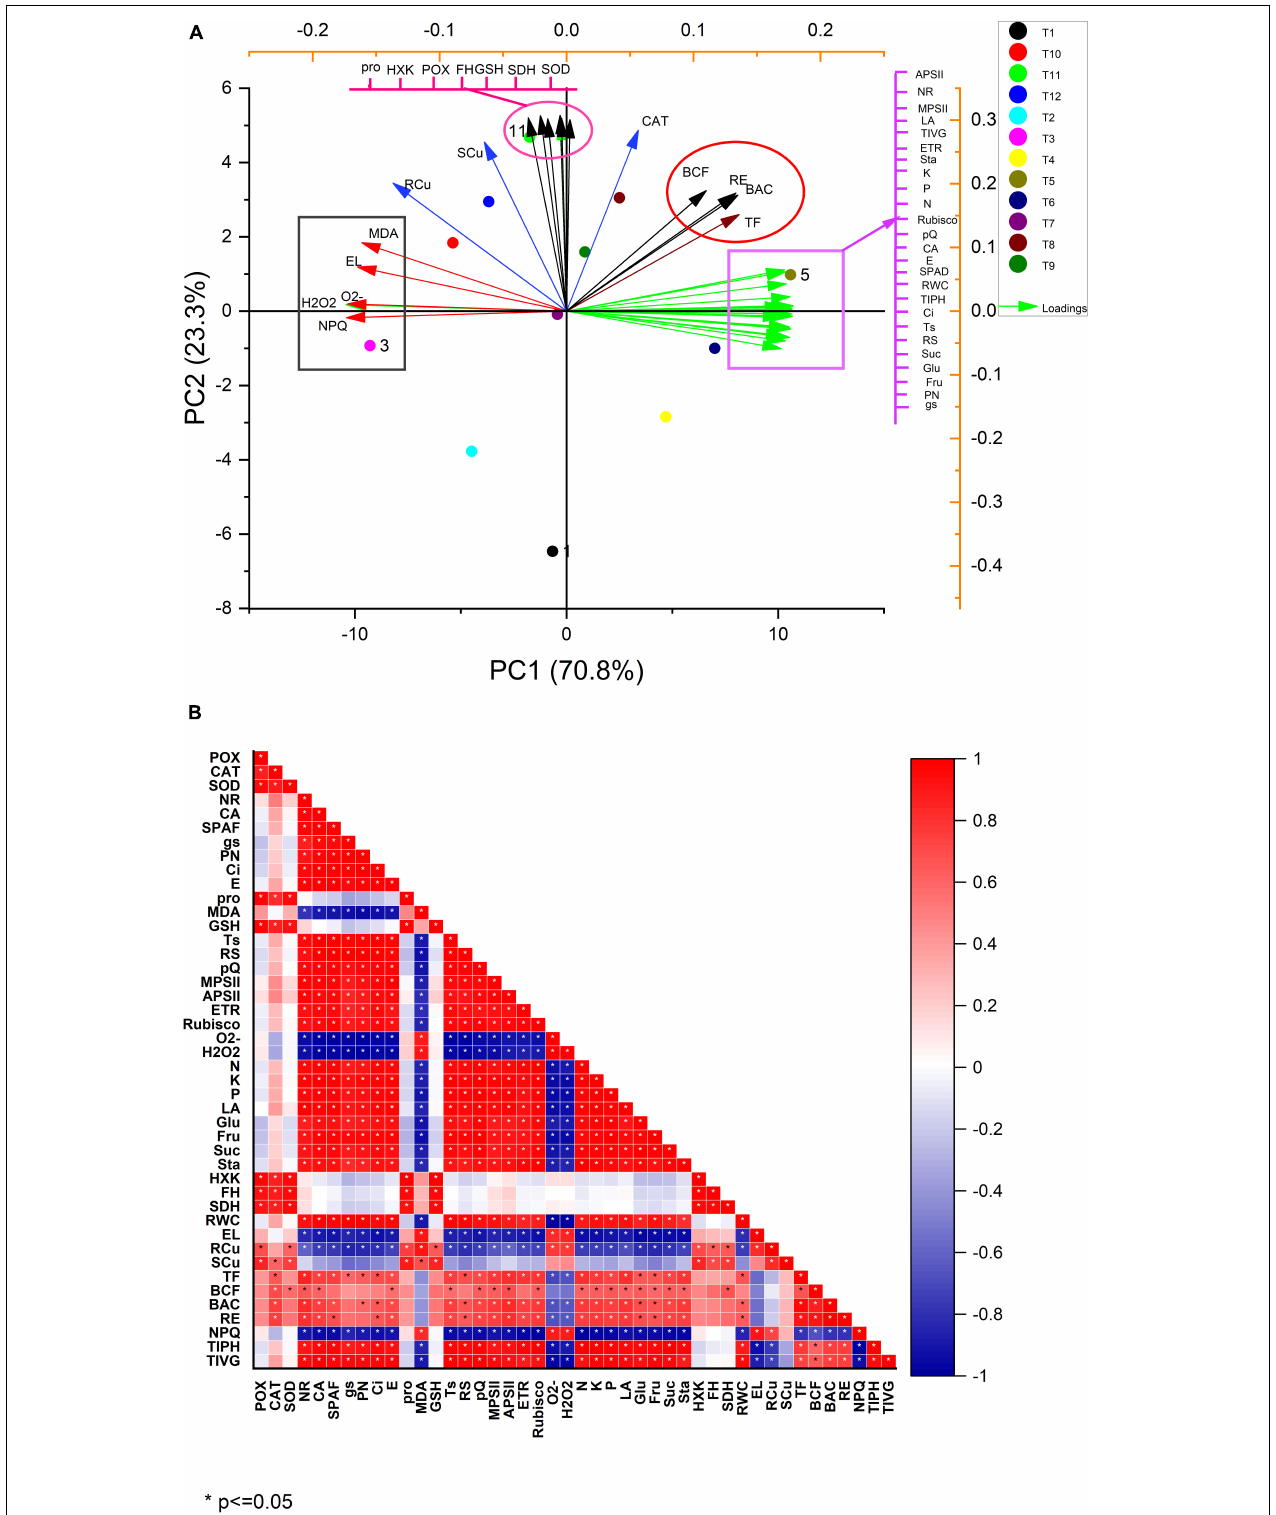
FIGURE 5 | Correlation analysis by (A) Pearson correlation and (B) PCA analysis. T 1 , Control; T 2 , Cu (30 mg kg − 1 ); T 3 , Cu (60 mg kg − 1 ); T 4 , MEL (30 µ M); T 5 , MEL (40 µ M); T 6 , MEL (50 µ M); T 7 , Cu (30 mg kg − 1 ) + MEL (30 µ M); T 8 , Cu (30 mg kg − 1 ) + MEL (40 µ M); T 9 , Cu (30 mg kg − 1 ) + MEL (40 µ M); T 10 , Cu (60 mg kg − 1 ) + MEL (30 µ M); T 11 , Cu (60 mg kg − 1 ) + MEL (40 µ M); T 12 , Cu (60 mg kg − 1 ) + MEL (50 µ